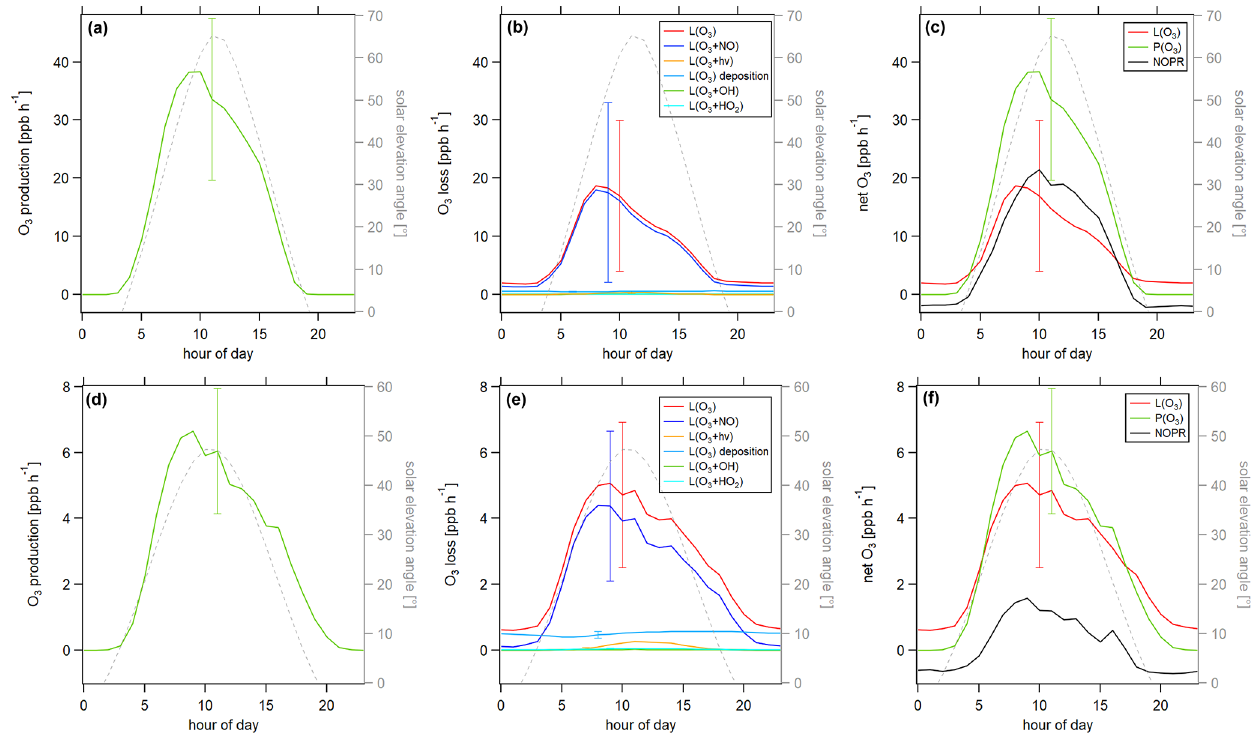
Figure 10. Diurnal profiles of O 3 production P (O 3 ) and loss L (O 3 ) terms during the HOPE campaign 2012 (top row) and the HUMPPA campaign 2010 (bottom row). (a) P (O 3 ), (b) L (O 3 ), (c) net O 3 , (d) P (O 3 ), (e) L (O 3 ) and (f) net(O 3